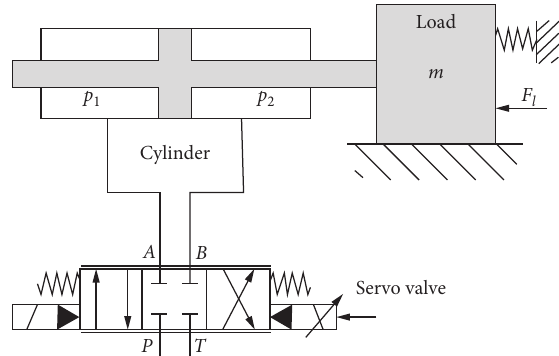
Figure 1: Model of valve-controlled cylinder position servo